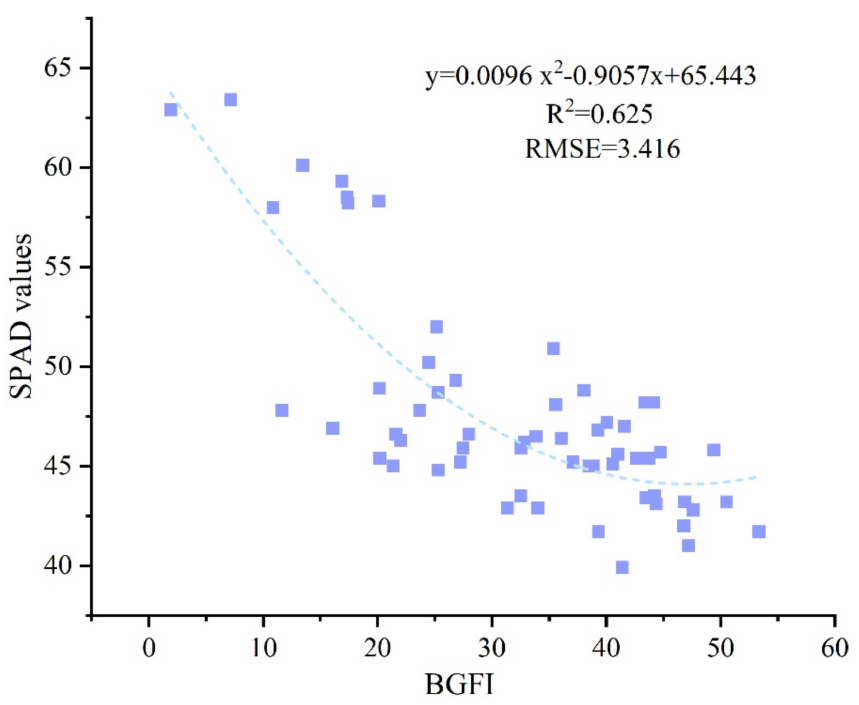
Figure 8. Critical N dilution curves derived from BGFI and SPAD values at 4 g N pot − 1